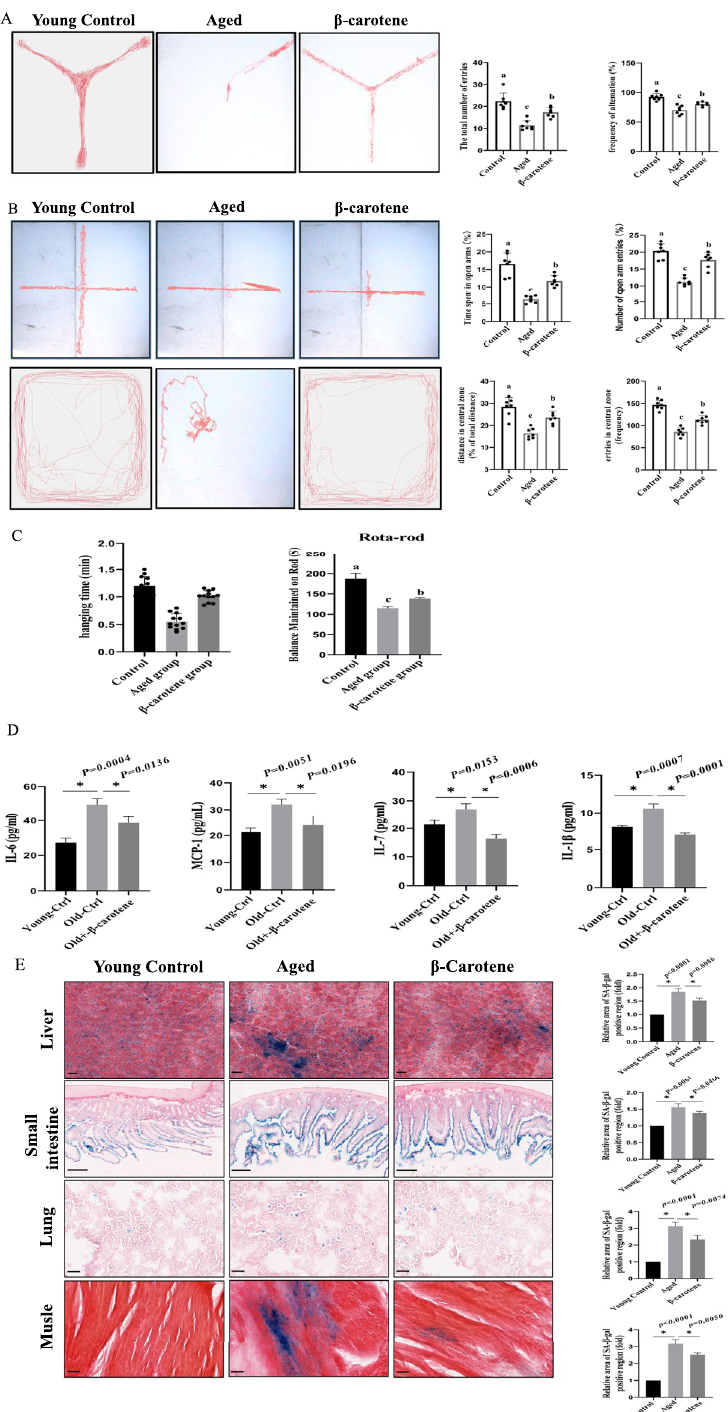
Fig. 10 The effects of β-carotene on the behavior of the aged mice. A The effect of β-carotene on learning and cognitive behavior of mice determined by Y-maze. n 5. B The effect of β-carotene on the anxiety by = EPM and OFT analysis. n 5. C β-Carotene improved the exercise ability of mice by hanging test and rotating = rod test. D β-carotene reduced the inflammation. E The aging level of tissues and organs was evaluated by Sa-β-gal. F The tissues injury was reduced by β-carotene treatment. G The effect of β-carotene on tissue